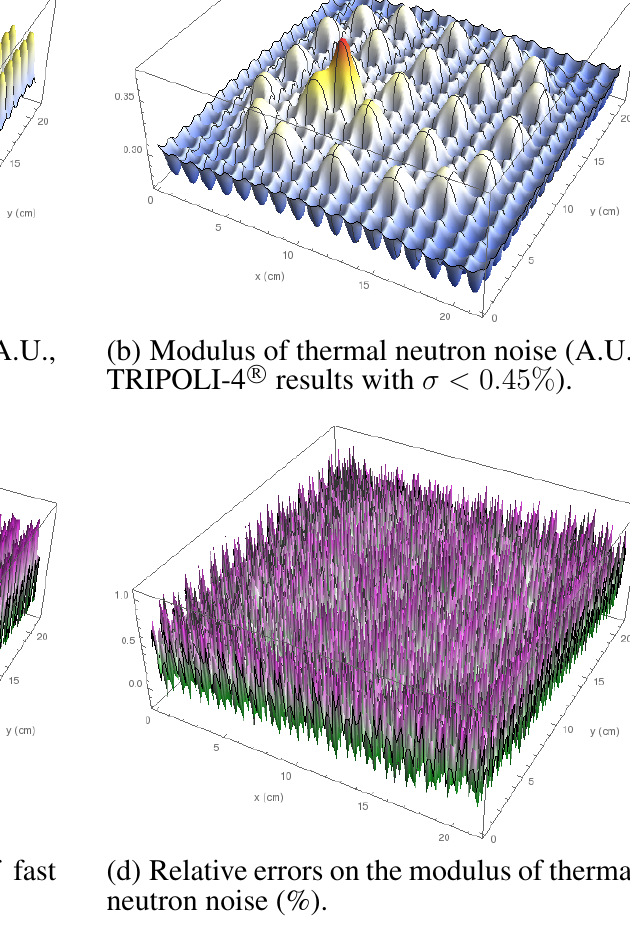
Figure 3: Results and relative errors (%) between TRIPOLI-4 R (cid:13) and APOLLO3 R (cid:13) on the modulus of δ Ψ( ω ) induced by a simple isotropic noise source at 3